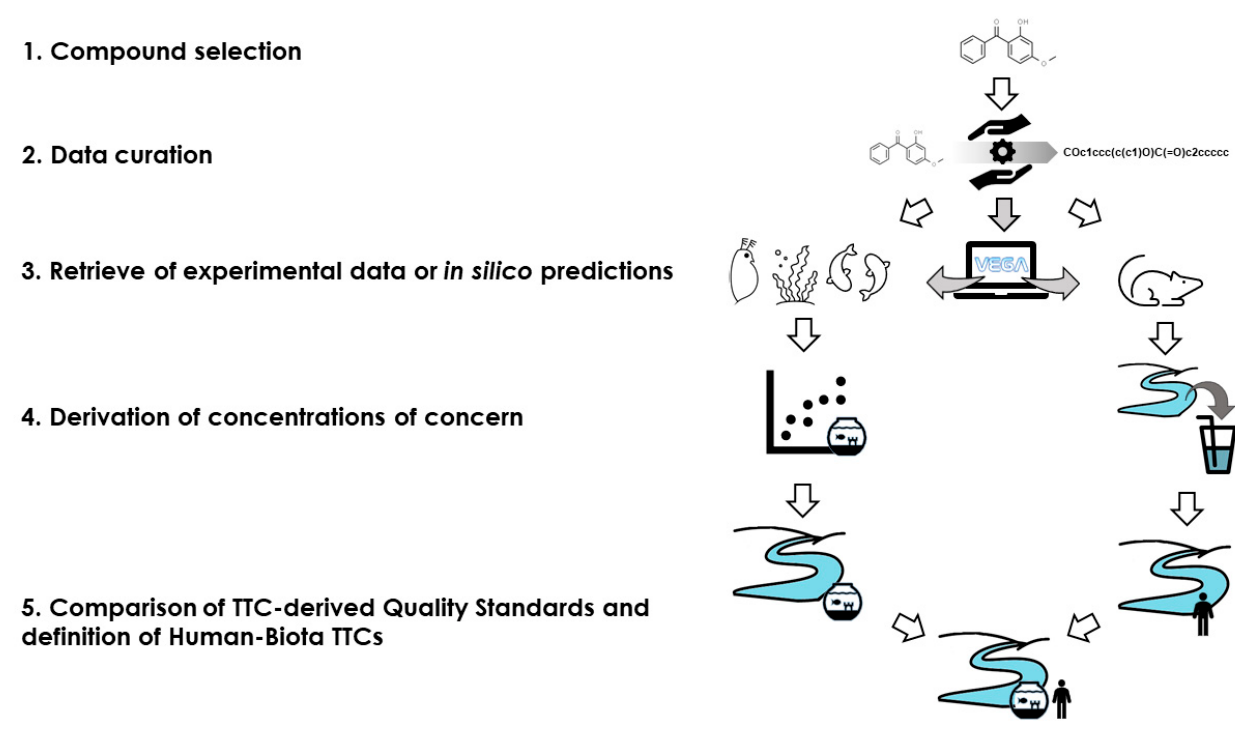
Figure 4. Scheme of the strategy to derive compound-specific Human-Biota TTCs.